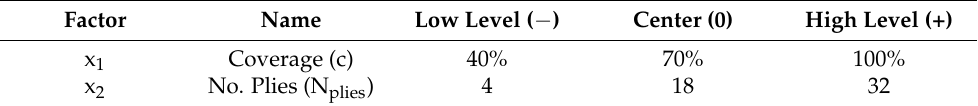
Table 4. CCD design points